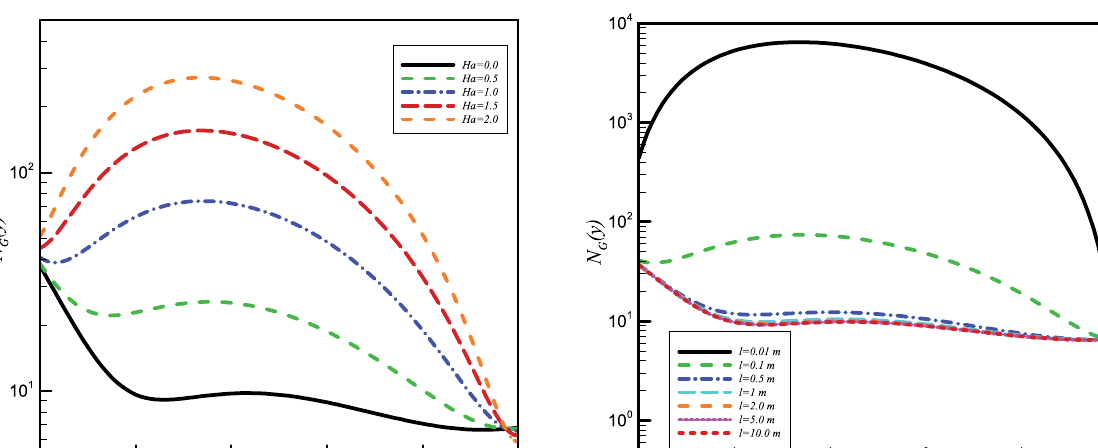
Fig. 15. Variation of entropy generation parameter, N G ( y ) , with respect to y for different values of Reynolds number.